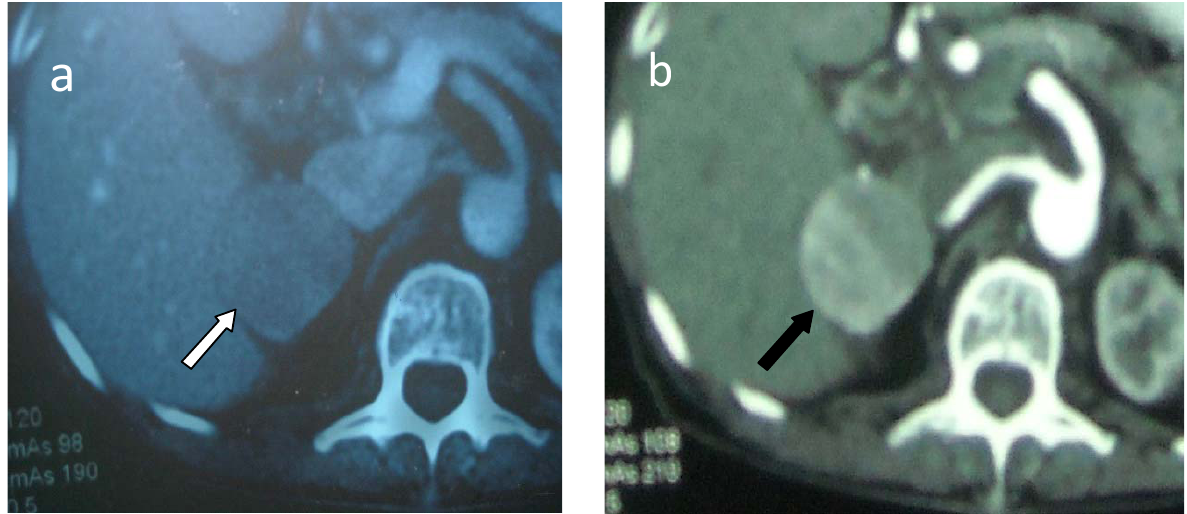
Figure 1. a) Pre-contrast CT scan showing the right sided well defined hypodense adrenal tumour (white arrow). b) Post-contrast CT image showing the contrast enhancement (black